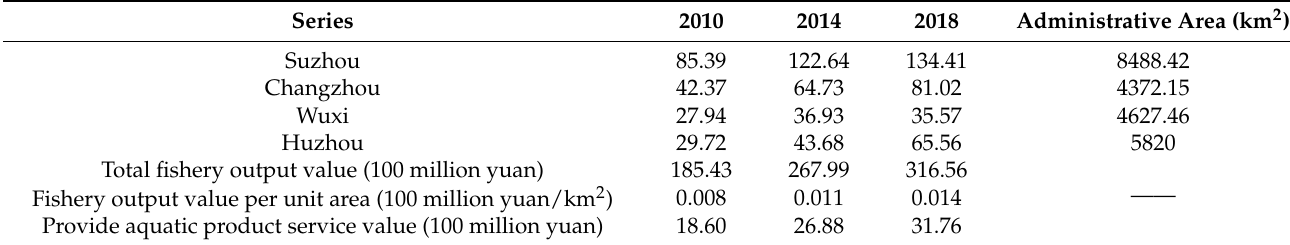
Table 7. Value of aquatic products provided by Taihu Lake during